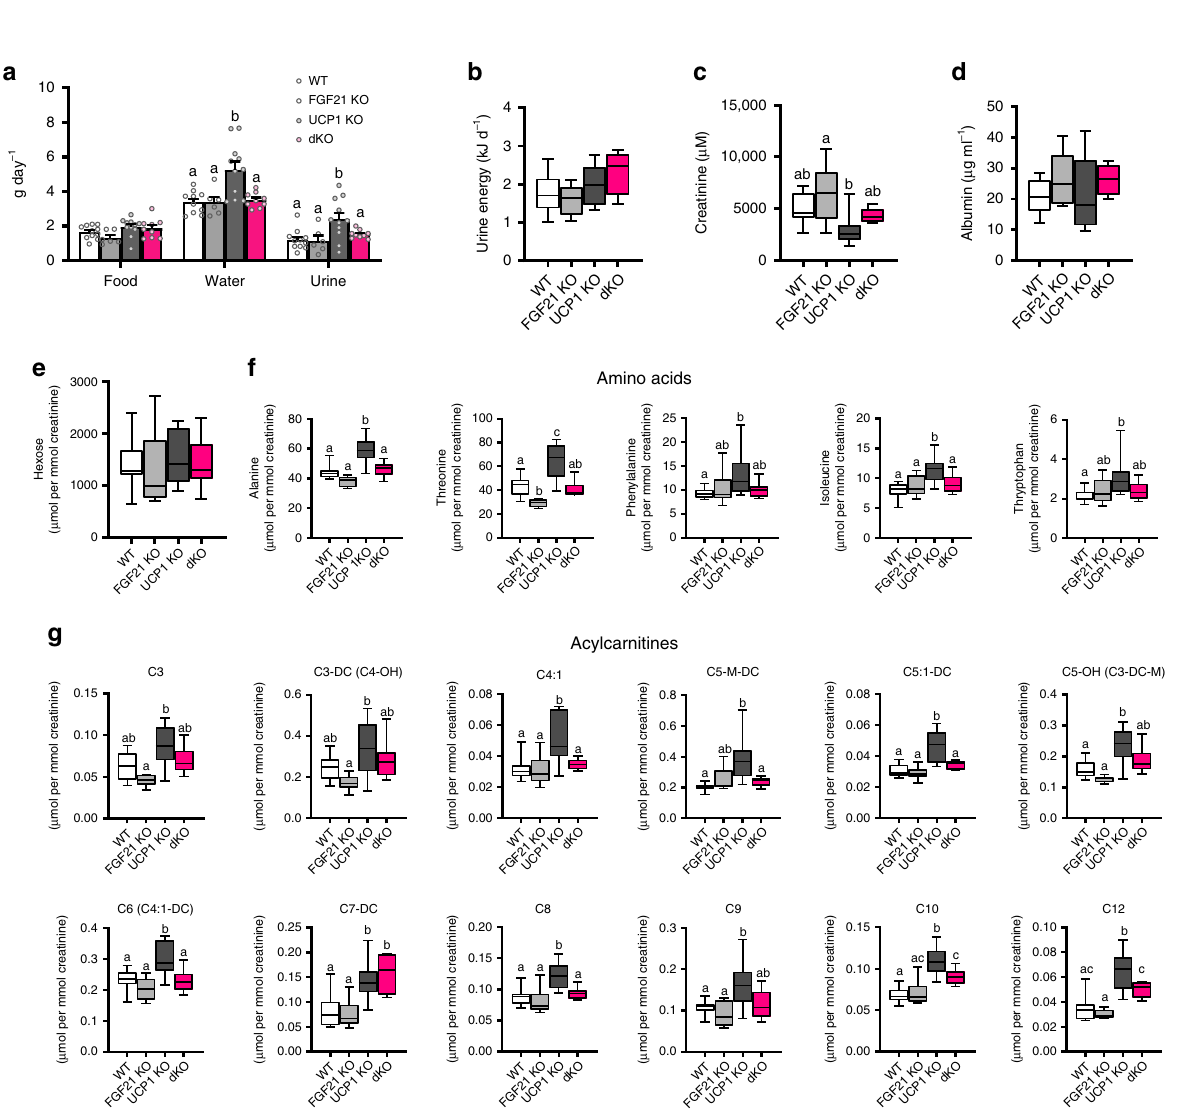
Fig. 4 Urine composition and excreted energy. After 6 wks of HFD feeding at room temperature, a food and water intake were determined and urine was collected. b Urine energy content, c urine creatine concentration, d urine albumin concentration, e urine hexoses, f urine amino acids, and g urine acylcarnitines were measured. Data are presented as box-plots, showing the metabolite distribution. The central mark indicates the median with the bottom and top edges of the box indicating the 25th and 75th percentiles, respectively. The whiskers extend to the most extreme data points. a (food and Urine), b , c , f (except Threonine), g : n = 11/6/11/9 WT/FGF21 KO/UCP1 KO/dKO; a (water): n = 10/6/11/9; d : n = 6/6/9/6; e : n = 11/6/10/9; f : n = 11/5/ 10/9; f (Threonine): n = 11/5/10/9. Data were analyzed by one-way ANOVA followed by Bonferroni test with different letters indicating signi fi cant differences ( P < 0.05). Source data are provided as a Source Data fi